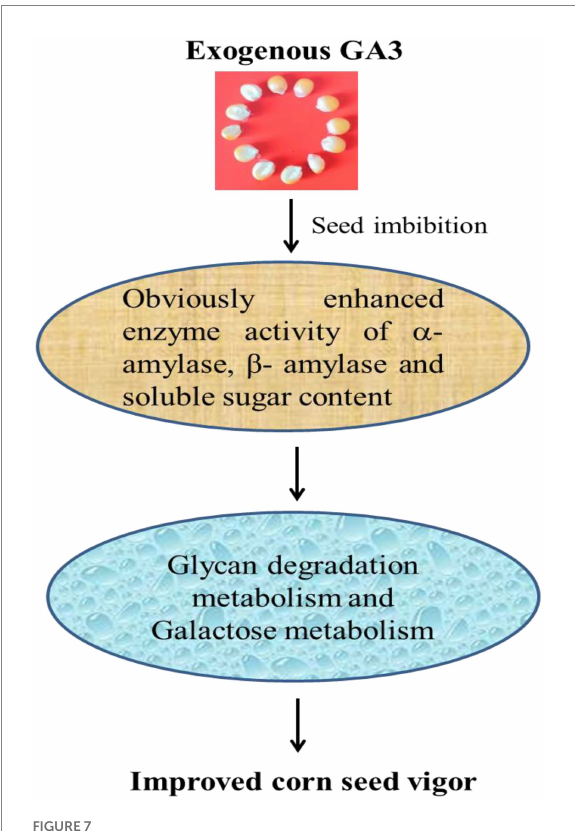
FIGURE 7 A regulation model for the improved maize seed vigor induced by